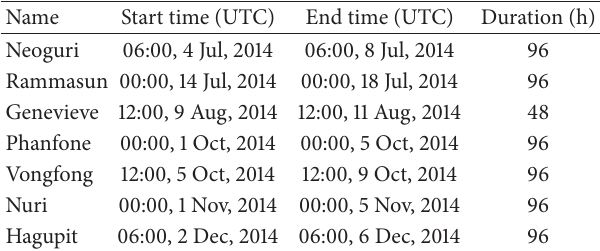
Table 1: Simulation periods and durations for super typhoon cases in